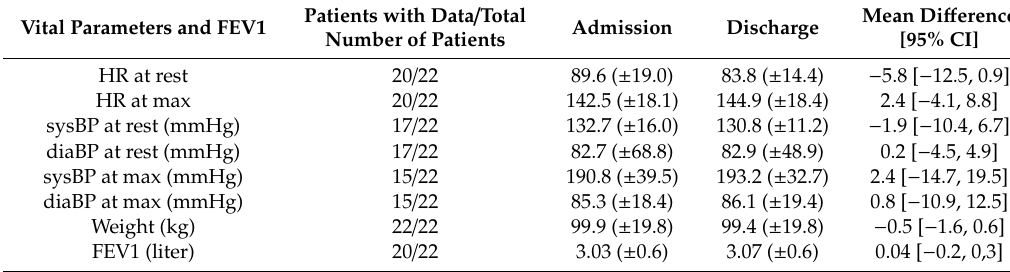
Table 3. Changes in vital parameters, weight and FEV1 at completion of pulmonary rehabilitation †